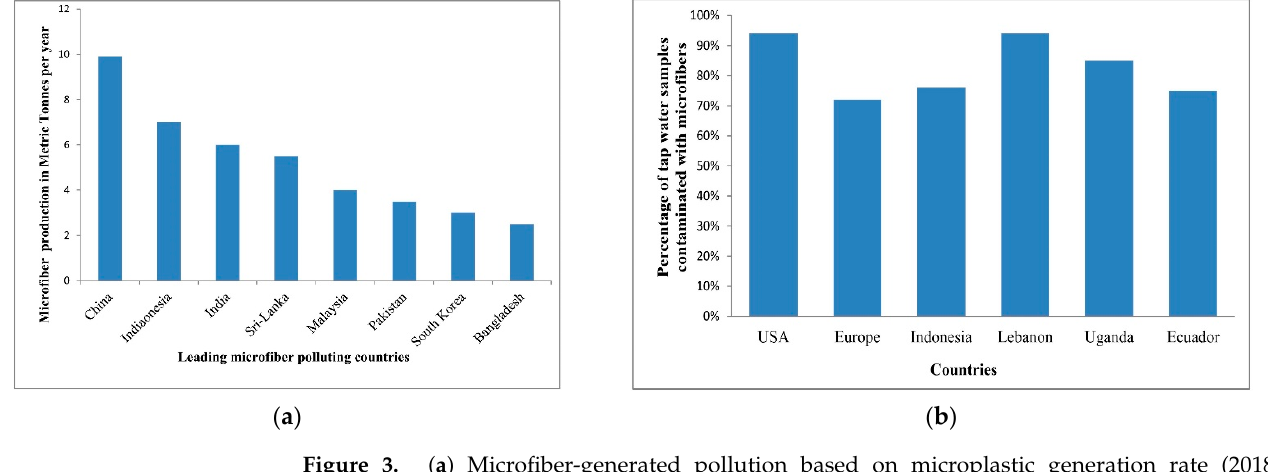
Figure 3. ( a ) Microfiber-generated pollution based on microplastic generation rate (2018); ( b ) micro- fiber contaminated tap water (2017), reprinted with permission from Ref.